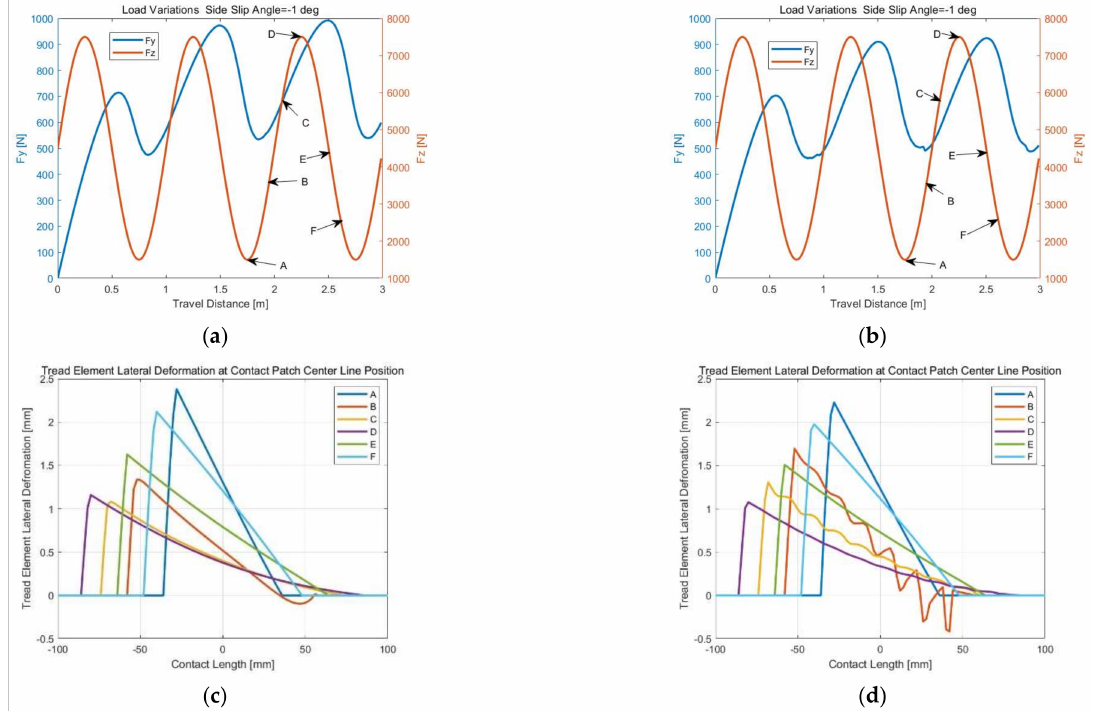
Figure 21. Lateral deformation of tread element at different traveling distance under load variations at a constant side slip angle. ( a ) Response of vertical force and lateral force for proposed method. ( b ) Response of vertical force and lateral force for the reference method. ( c ) Tread deformation at different positions for the proposed method. ( d ) Tread deformation at different positions for the reference